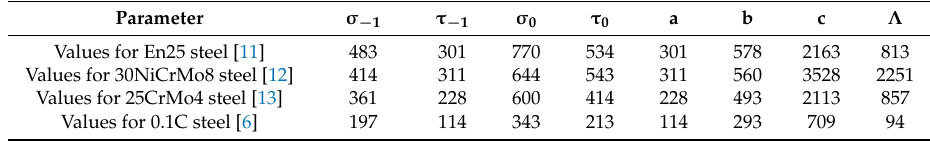
Figure 13. Haigh diagram with the experimental results for several structural steels [6,11–13] and their predictions from the proposed method, Equation (17). Table 8. Parameters of the proposed method applied to several structural steels extracted from the literature [6,11–13]. All the values of τ 0 were estimated by means of Equation (20). The value of τ − 1 for the 30NiCrMo8 quenched and tempered steel [12] was estimated by means of Equation (19b).